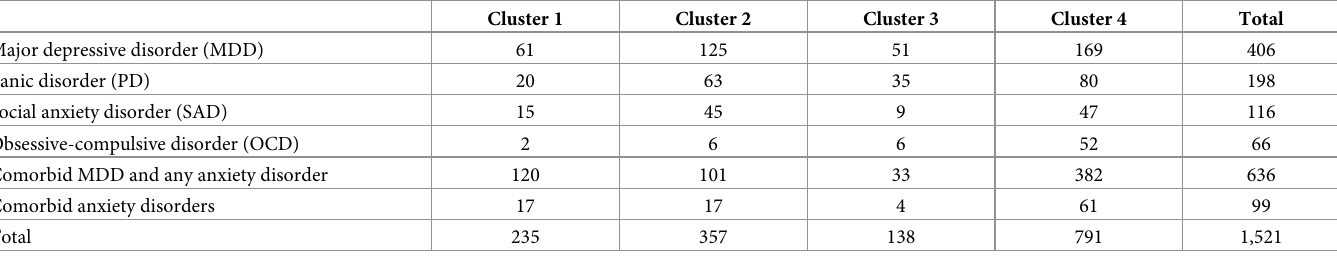
Table 1. Participants’ allocations to the Gaussian graphical mixture model (GGMM)-based clusters ( N =